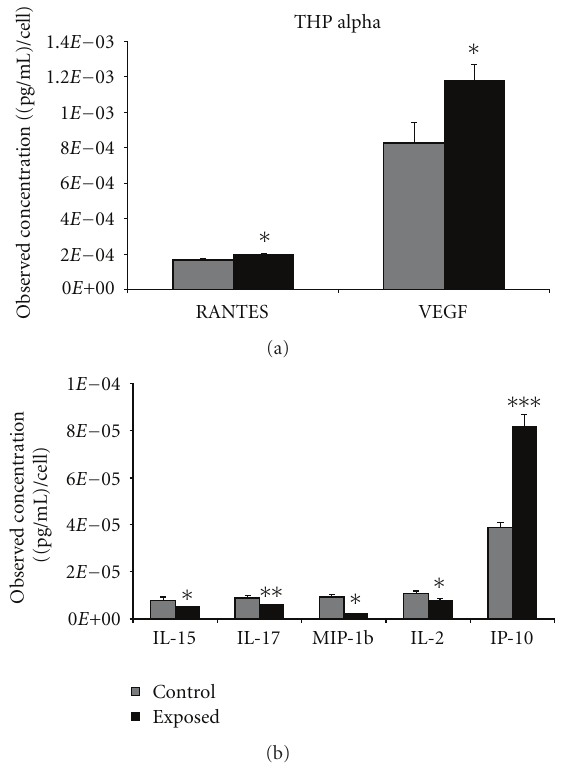
Figure 3: THP-1 cells were seeded into Mylar dishes and exposed to α -particle radiation at 0 and 1.5Gy. A Bio-plex cytokine assay was performed quantitating 27 di ff erent cytokines, and the results showing statistical significance between control and exposed groups are presented. ∗ represents P < 0 . 05, ∗∗ represents P < 0 . 01, and ∗∗∗ represents P < 0 . 001, n = 5 biological replicates performed in duplicate. Bars are plotted as cell count corrected means ± SEM.